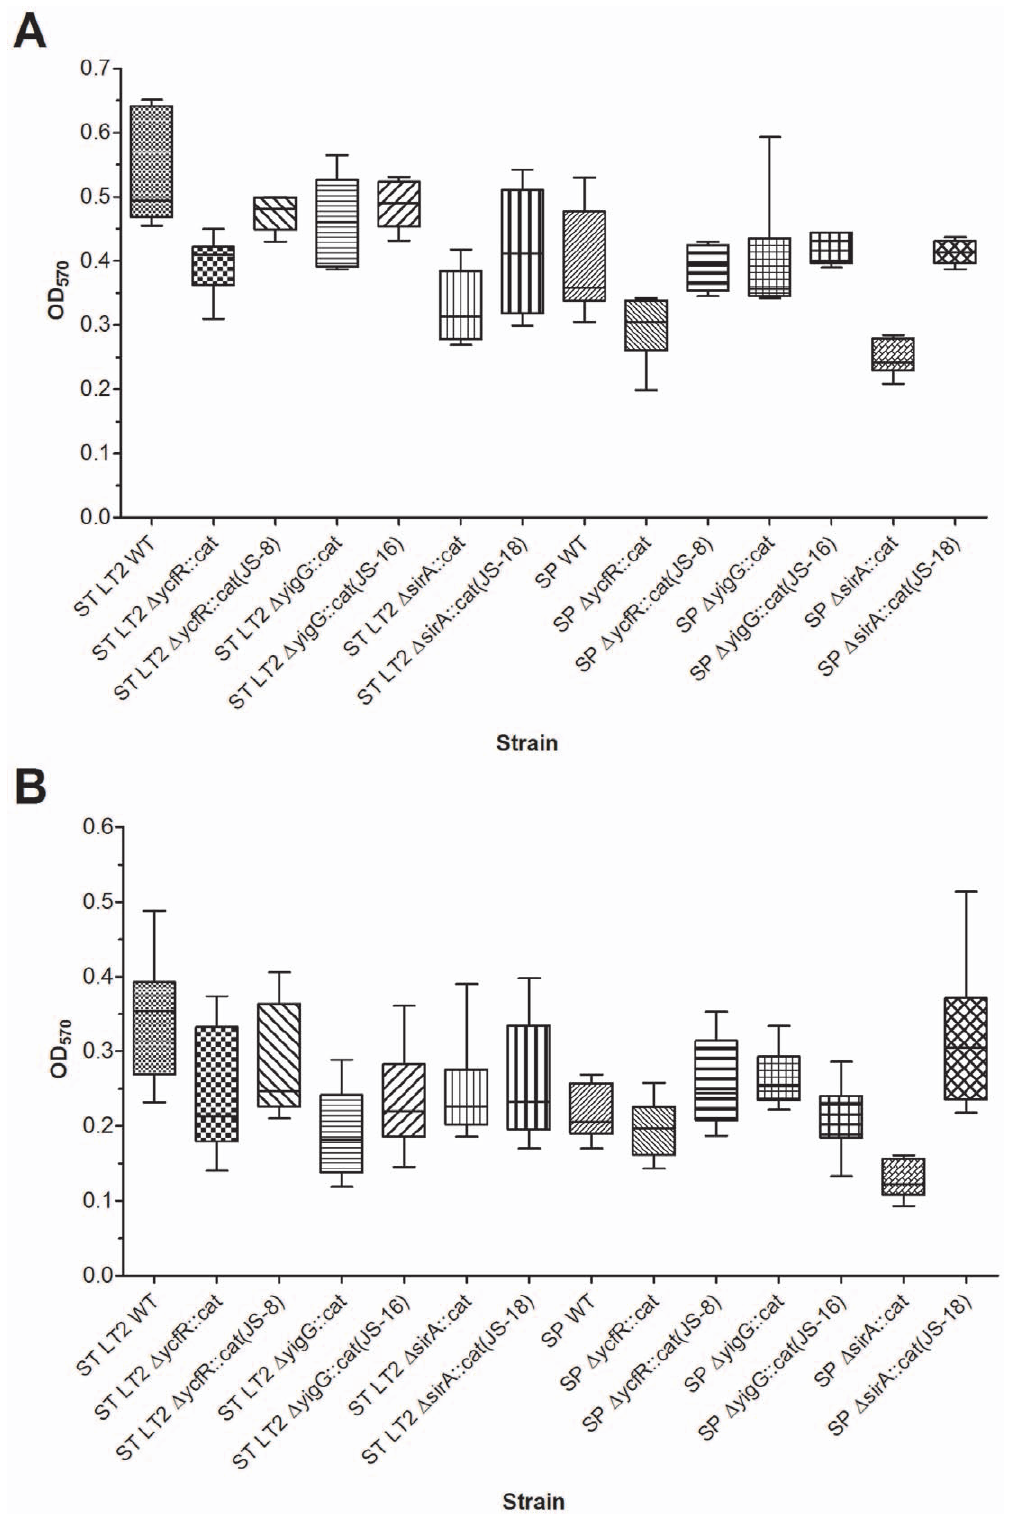
Figure 4. S.enterica crystal violet attachment assays. The bacterial attachment is quantified by OD 570 readings. A) Quantification of bacterial attachment in glass test tubes. B) Quantification of bacterial attachment in polystyrene 96-well plates. All assays were conducted for 24 h at 37 u C. Middle horizontal line in each box represents the median of the entire data set; the upper and lower horizontal lines represent the upper quadrant median and the lower quadrant median, respectively. Detailed data analysis is given in Table 2.